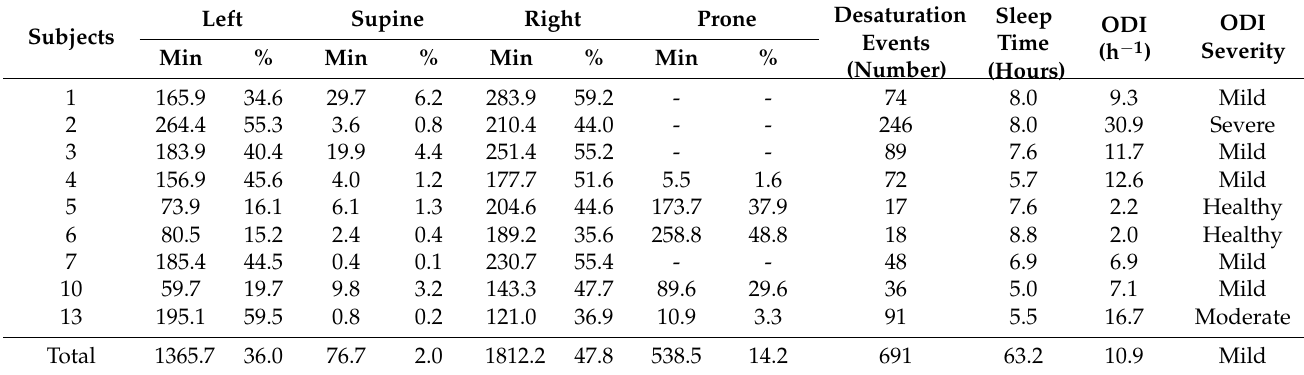
Table 3. Time spent in each sleep position in minutes (Min) and percentage (%), number of desaturation events, total sleep time, ODI, and ODI severity for the subset of subjects who underwent positional treatment.